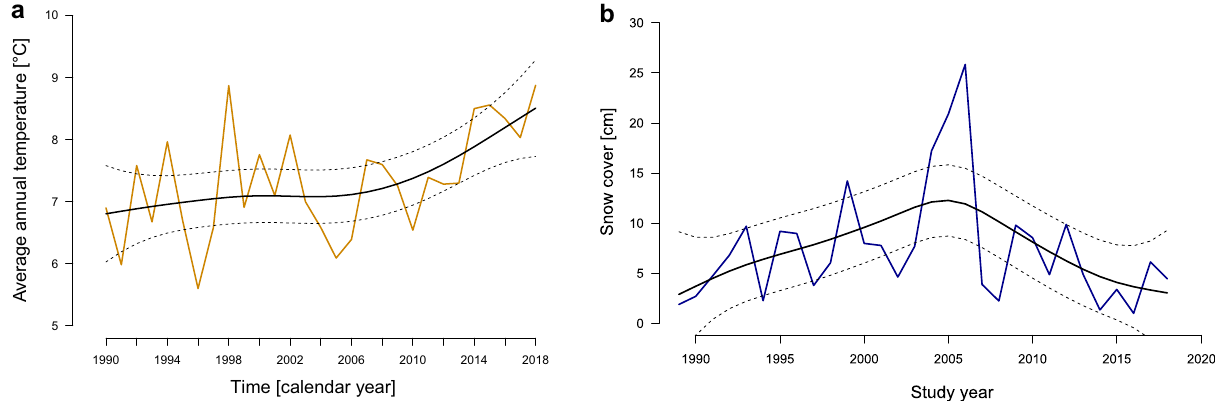
Figure 1. ( a ) Average annual temperature [°C]; and ( b ) annual snow depth [cm] over the course of the study period (1990–2018). Cubic regression spline smoothers with 95% confidence intervals were added to aid visual interpretation. The smoothers explain 35.8% and 28.1%, respectively, of the deviance.